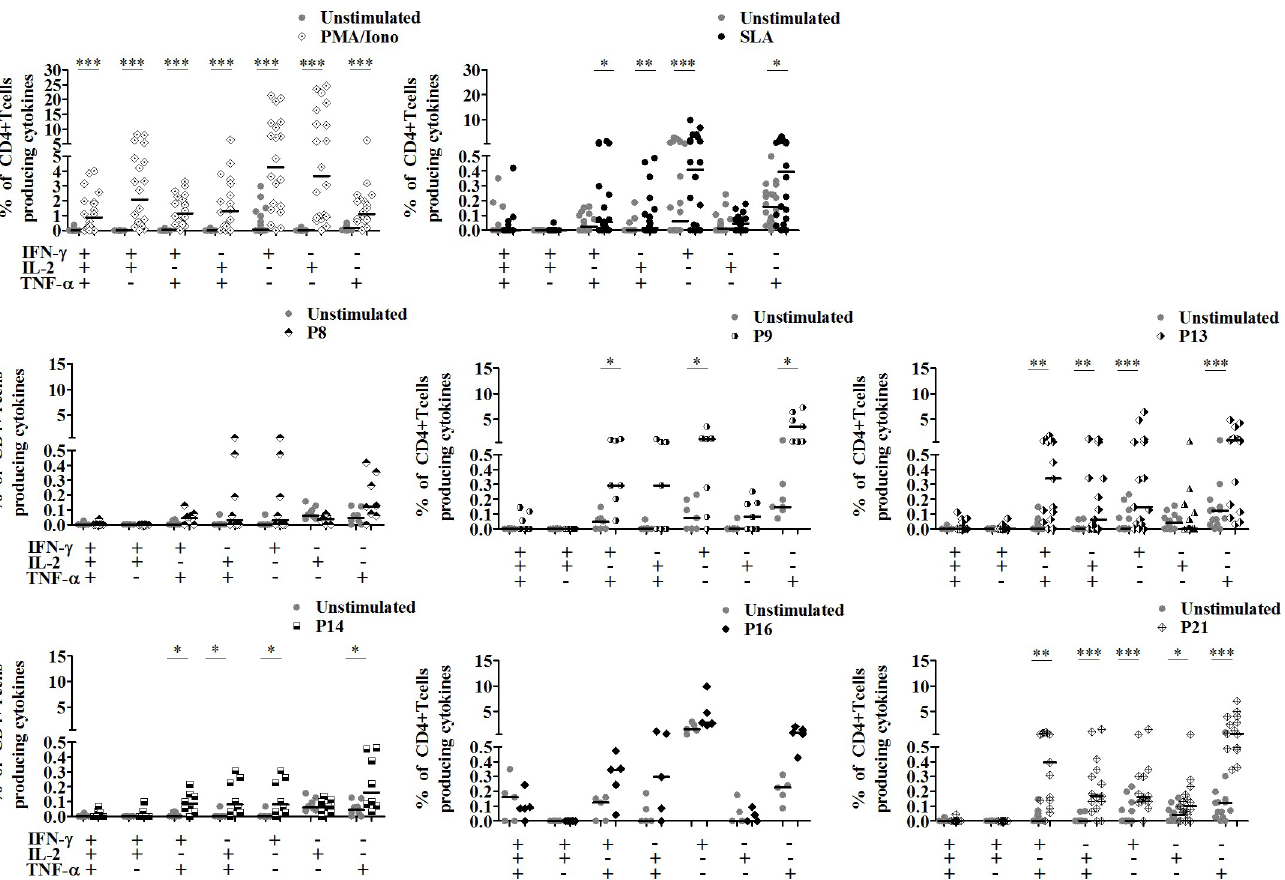
Fig 10. Multifunctional CD4+ T cell responses after multi-epitope peptide pools stimulation. PBMC from cured CL subjects (5 to 15 individuals), previously stimulated with selected peptide pools (1 μ M/peptide) for 10 days were re-stimulated overnight with the same peptide pools (1 μ M/peptide) and with anti-CD49d/ anti-CD28 antibodies (1 μ g/ml). For intracellular cytokine detection, cells were treated with Golgistop for 6 h of culture, fixed and permeabilized using BD Cytoperm/cytofix kit. Data were analyzed by FlowJo software. PBMC stimulated with PMA (50 ng/ml)/Ionomicyn (10 –6 M) for 6 h or SLA (10 μ g/ml) for 5 days, were used as positive control. A five-color flow cytometry panel was used to simultaneously analyze multiple cytokine at the single cell level. Boolean combinations of the three cytokine gates (IFN- γ , IL-2 and TNF- α ) were used to uniquely discriminate responding cells based on their functionality. The frequency of CD4+ T cells expressing each of the seven possible combinations of IFN- γ , IL-2 and TNF- α was determined. Horizontal bars represent median values. Statistical significance was assigned to a value of p < 0,05 ( � p < 0.05, �� p < 0.01, ��� p <